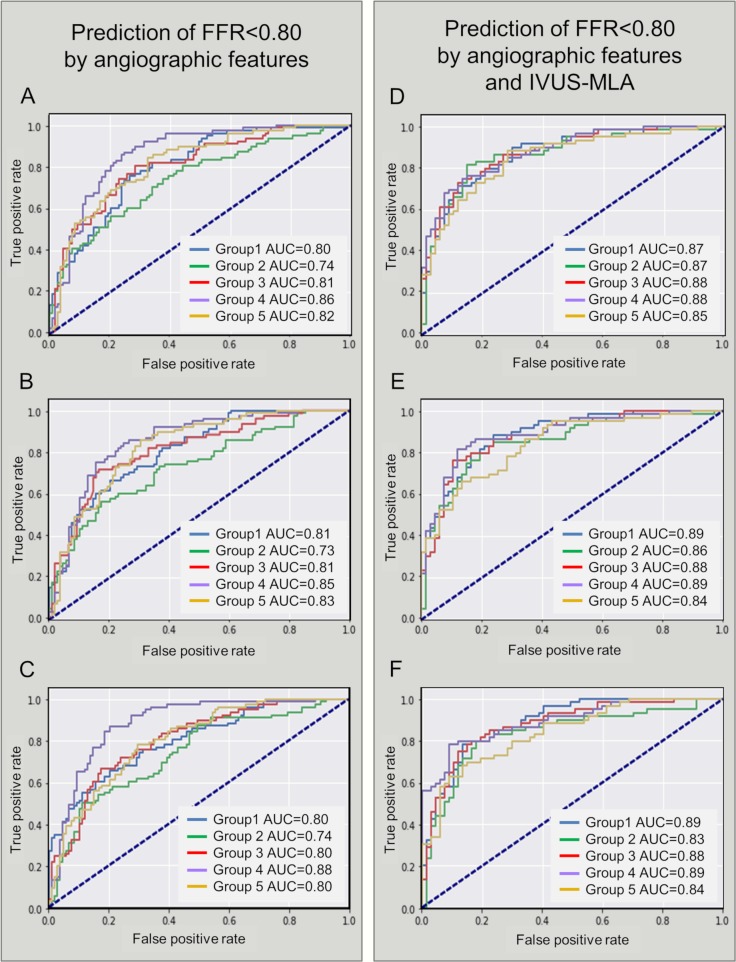
ROCs for predicting FFR < 0.80 in the training sample (N = 932).(A) L2 penalized logistic regression using angiographic features. (B) Random forest using angiographic features. (C) CatBoost using angiographic features. (D) L2 penalized logistic regression using angiographic features and IVUS-MLA. (E) Random forest using angiographic features and IVUS-MLA. (F) CatBoost using angiographic features and IVUS-MLA. AUC, area under the curve; FFR, fractional flow reserve; IVUS-MLA, intravascular ultrasound–derived minimal lumen area; ROC, receiver operating curve.